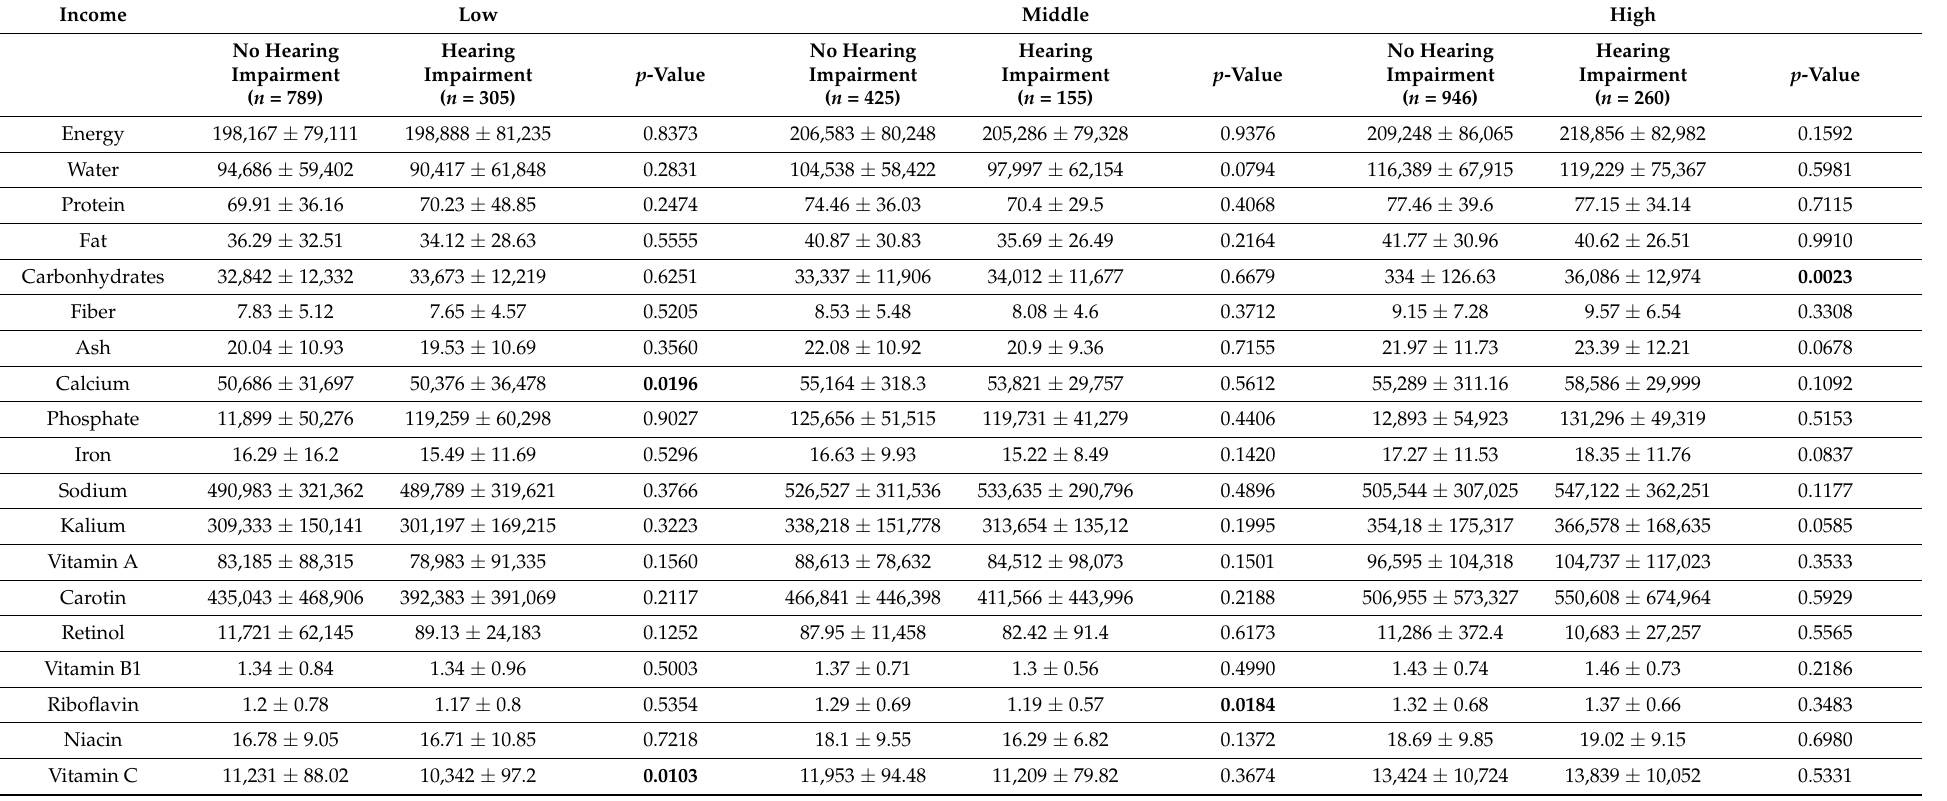
Table 6. Differences in nutritional intake between normal hearing and hearing loss according to amount of income (Simple